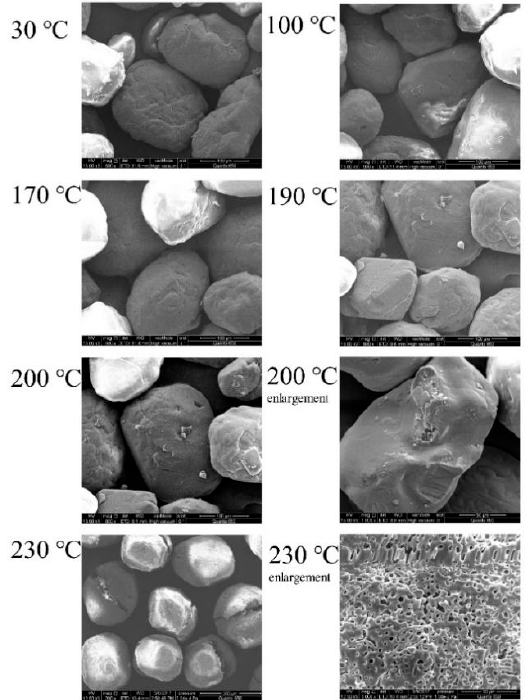
Figure 5. AP surface conditions at different temperatures.